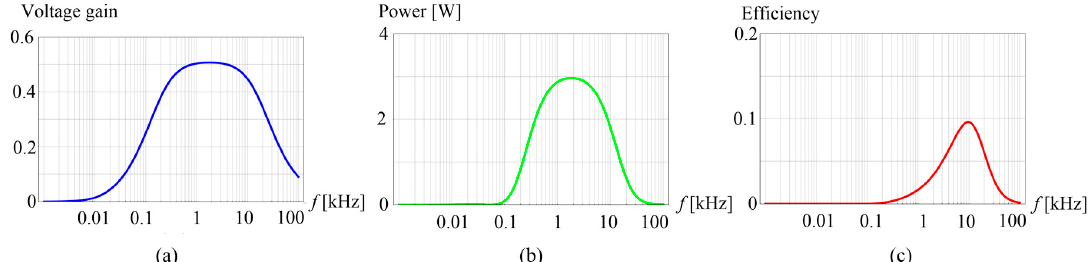
Figure 11. ( a ) Curve chart of voltage gain related to frequency; ( b ) Curve chart of power related to frequency; ( c ) Curve chart of efficiency related to frequency. ( f : frequency).